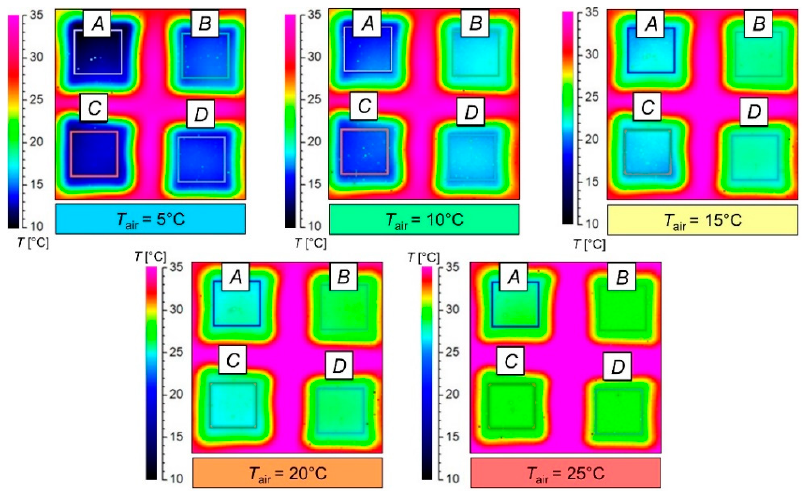
Figure 7. Thermograms of tested assemblies obtained in five different ambient conditions (analyzed surface area: 10 mm × 10 mm—indicated by square).